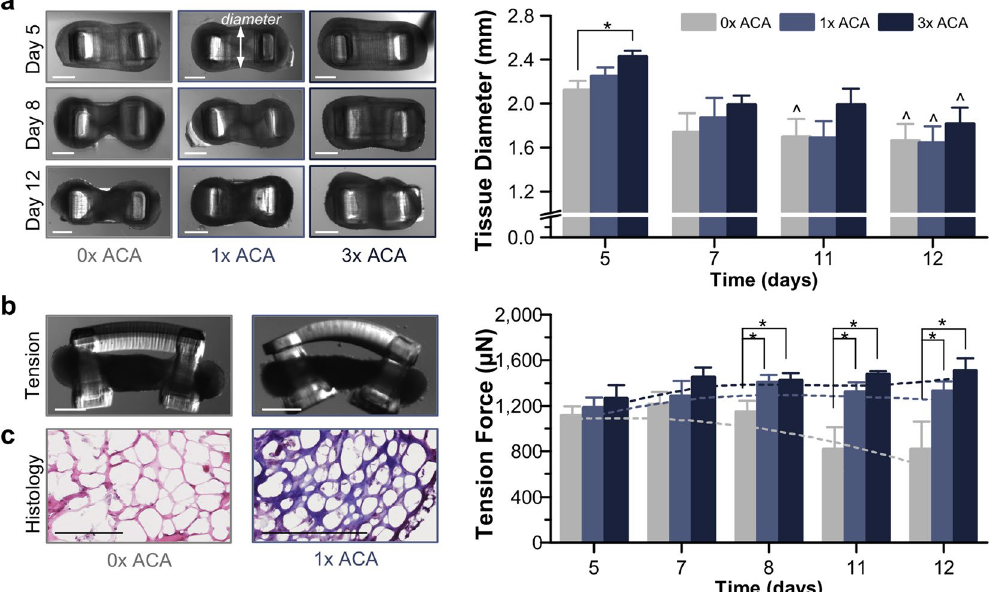
Figure 4. Loss of Tissue Structure and Mechanical Integrity. ( a ) Muscle strips began to degrade (most notably, in the middle region of the tissue), as shown in top-view images. Though the diameters of all groups on day 12 were reduced, the addition of 3x ACA helped to maintain the integrity of the tissue longer ( n = 2–9 muscle strips per condition). Scale bar, 1 mm. ( b ) Muscle strips cultured without ACA displayed a lower passive tension and faster decrease in static force over time. After day 8, the passive tension was significantly lower for 0x muscle strips ( n = 4–7 per time point) compared to both 1x ( n = 5–6 per time point) and 3x ACA ( n = 5–7 per time point). Scale bar, 1 mm. All plots represent mean ± SEM. * indicates significance ( p < 0.05) between conditions at the same time point; ^ indicates significance compared to initial time point. ( c ) Histological staining for Masson’s Trichrome indicated that the addition of ACA helped to maintain the ECM in muscle strips. Scale bar, 200 μ